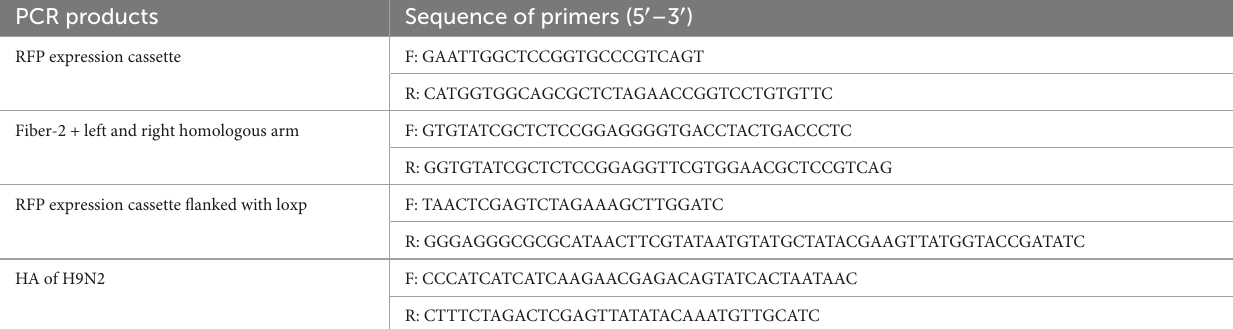
TABLE 2 List of primers for constructing donor plasmid. PCR products